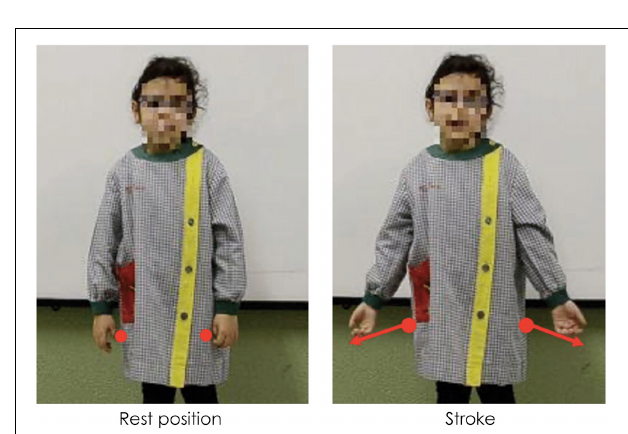
FIGURE 6 | Caption of a biphasic non-referential gesture while saying “hi havia un COTXET” (“there was a SMALL CAR”). Capitalization indicates the word accompanied by a